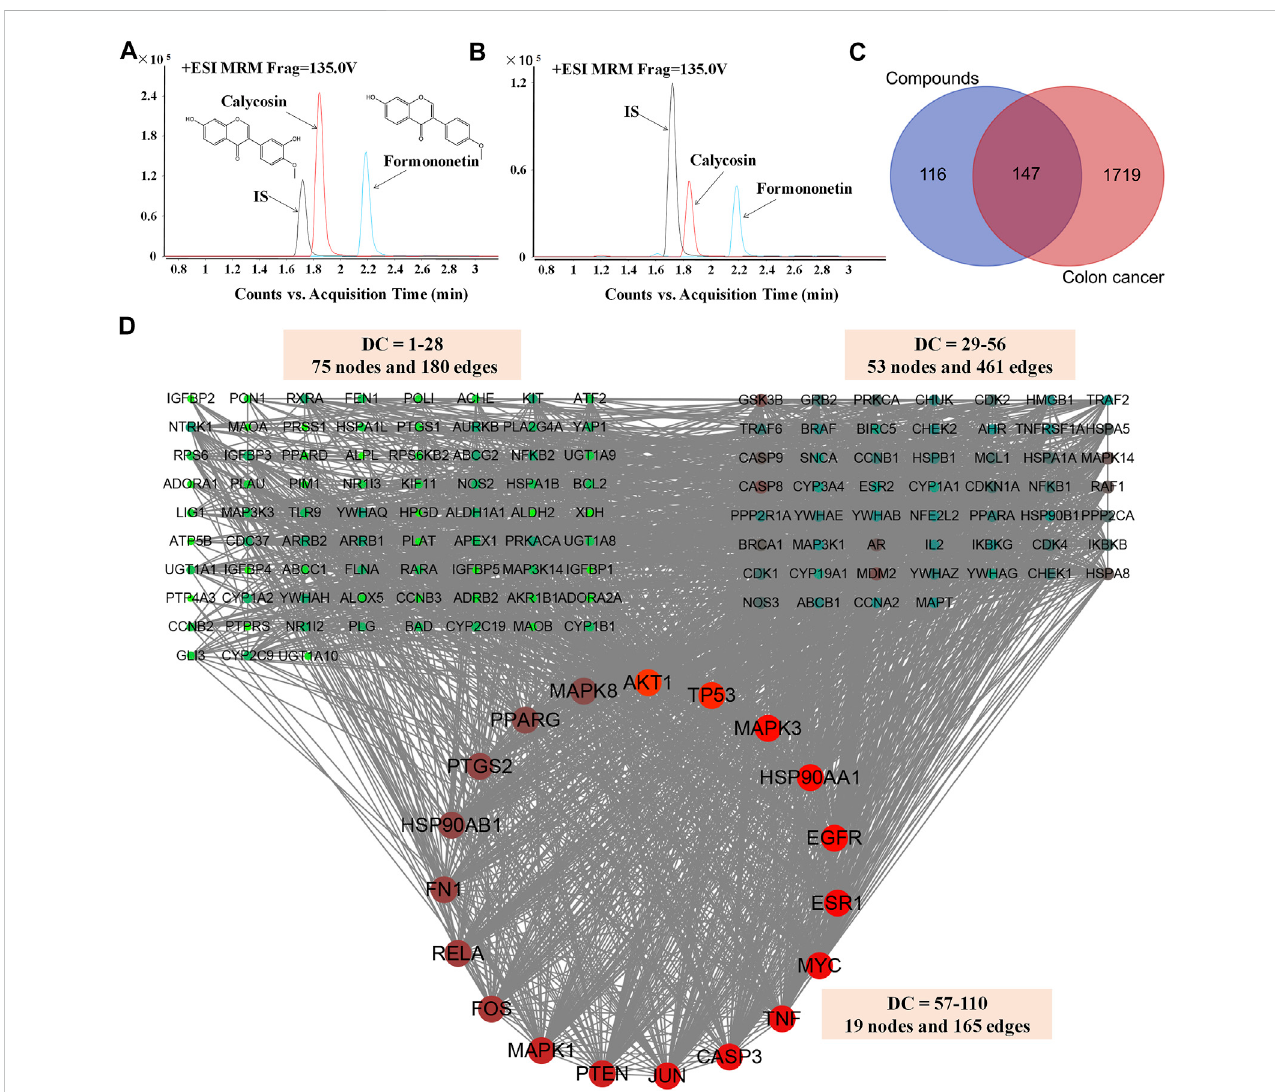
FIGURE 2 Screening and analysis of the common targets of FMNT and CS for the treatment of colon cancer. The content of FMNT and CS were quantitated in HQ water extract using erlotinib as an internal standard (IS) (A) A chromatogram of FMNT and CS standard solution (B) A chromatogram of FMNT and CS in HQ water extract (C) Venn diagram of compounds (FMNT and CS)-colon cancer intersection targets. The 1866 targets of colon cancer were mapped to the 263targetsofFMNTandCStoscreenoutthe147commontargets (D) ThePPInetworkofthe147nodes.Therednodesrepresentthebighubnodes,the green nodes represent the other nodes. The node size is proportional to its